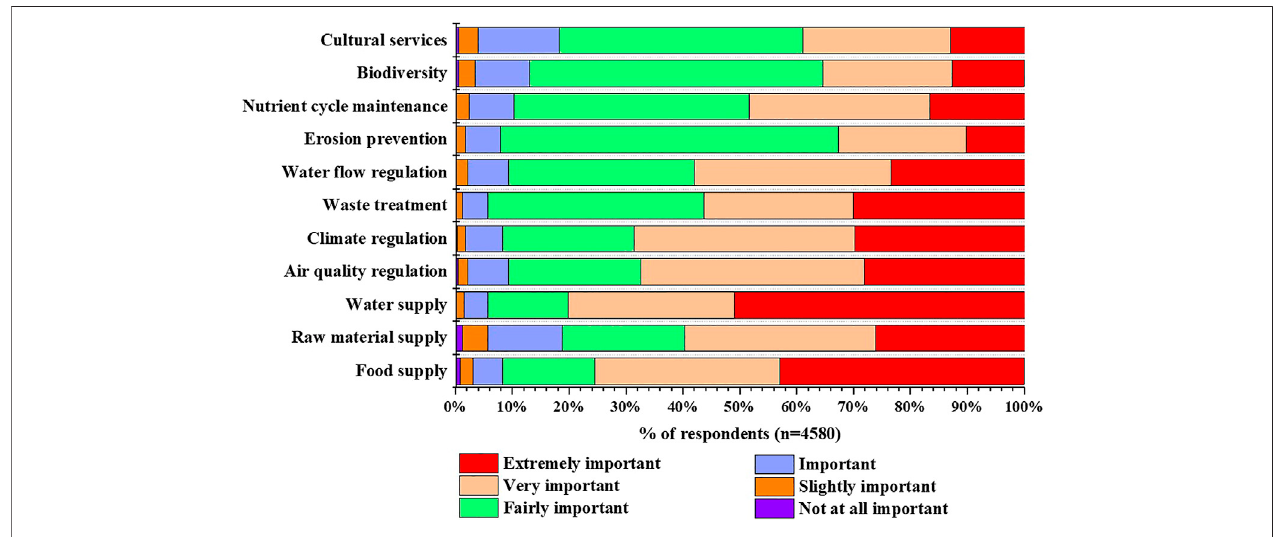
FIGURE 2 | Proportion of ESs perceived